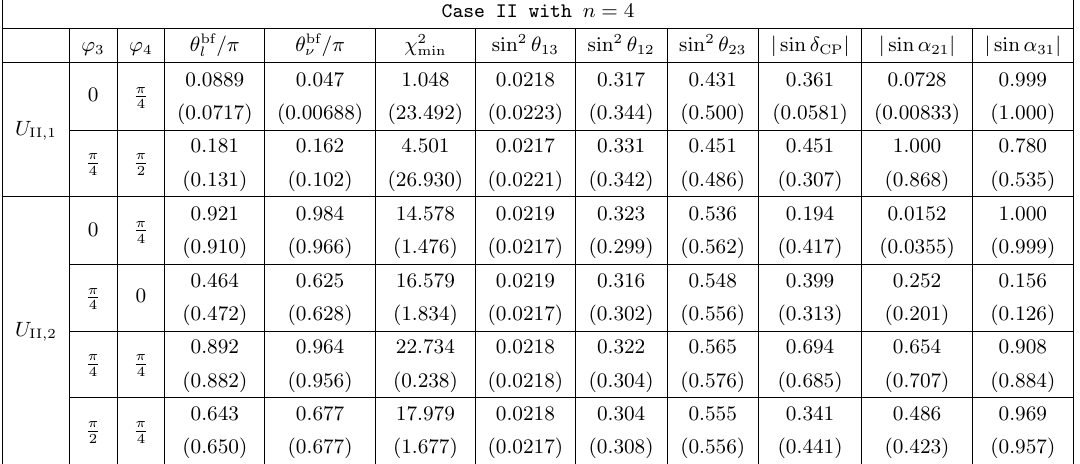
Table 7 . Results of the (cid:31) 2 analysis for n = 4 in case II. The (cid:31) 2 function obtains a global minimum (cid:31) 2 at the best (cid:12)t values ( (cid:18) l ; (cid:18) (cid:23) ) = ( (cid:18) bf ; (cid:18) bf ). We display the values of the mixing angles and CP (cid:23) min l violation phases at the best (cid:12)tting point. The numbers given in parentheses are the corresponding results for the inverted hierarchy neutrino mass spectrum. Here we do not show the results of ’ 3 = ’ 4 = 0 for which all the three CP phases are